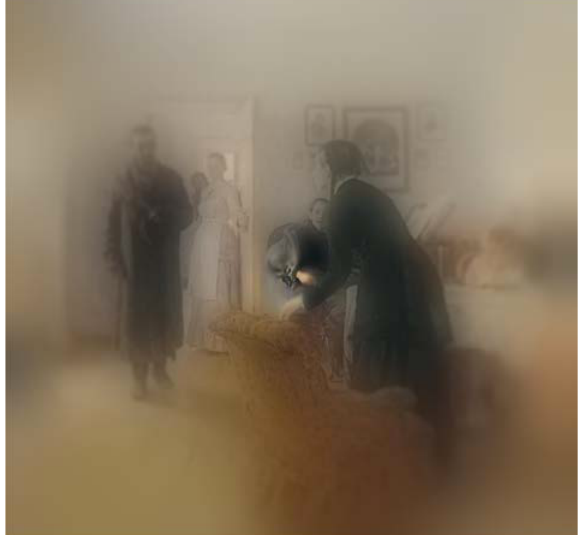
Figure A.3. Foveated image obtained by augmenting result of Geisler and Perry algorithm with rod distribution. Since rods do not contribute to color vision, only the luminance channel has been affected (rods account for 30% and cones for 70% of spatial